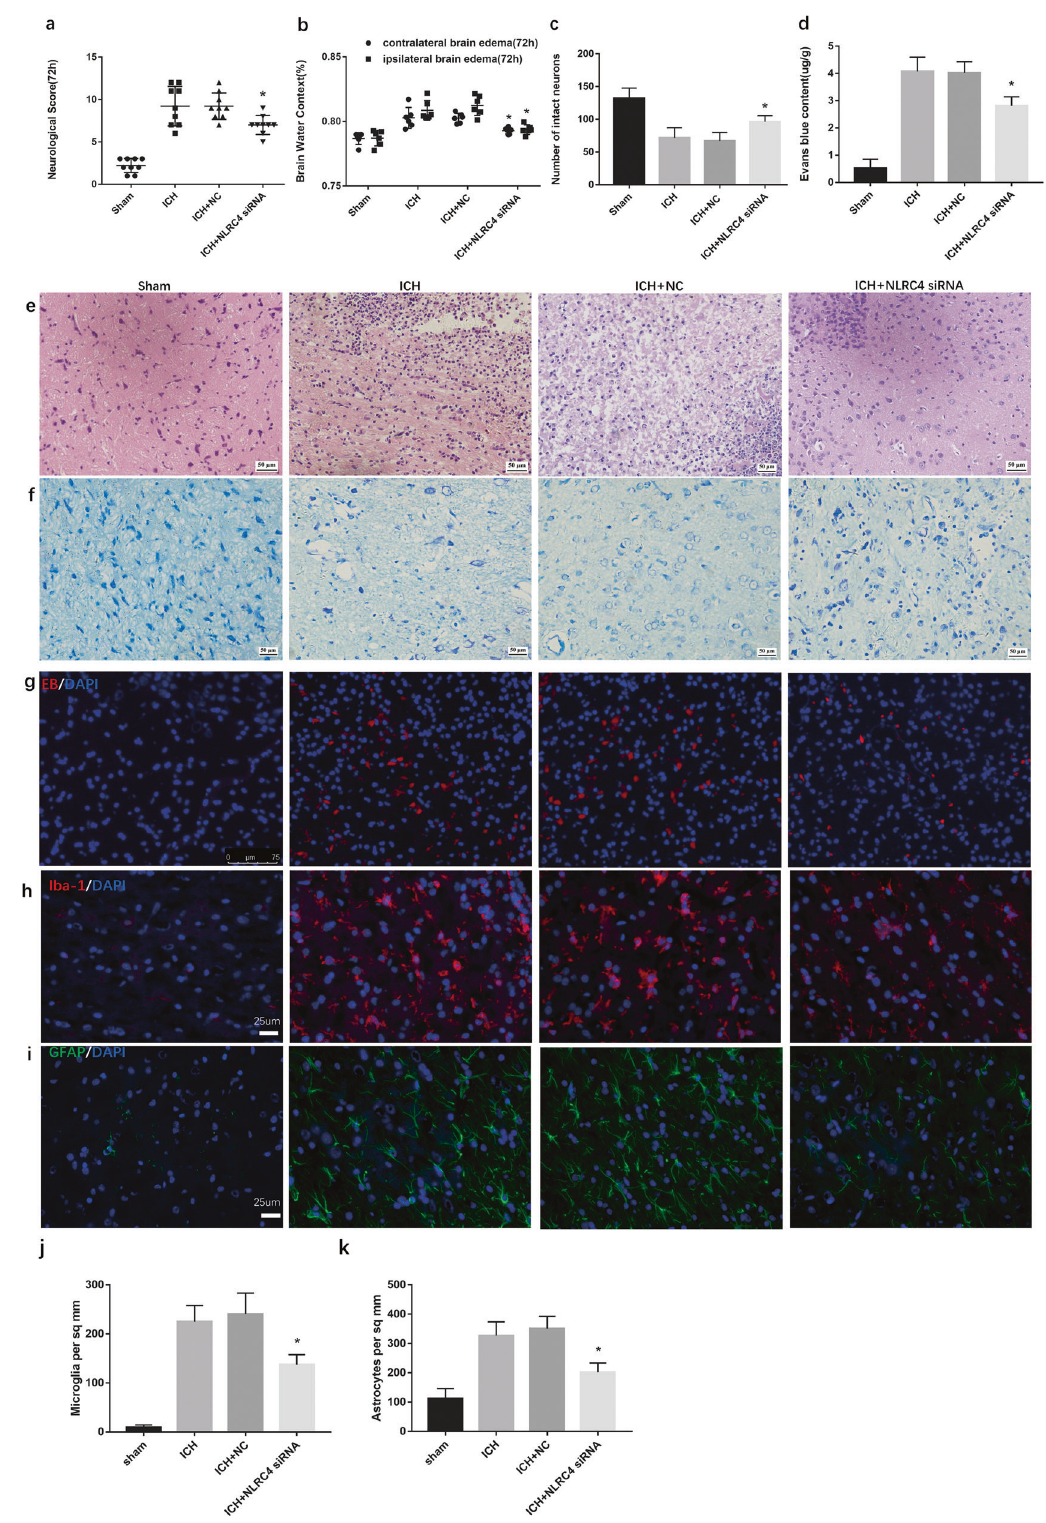
Fig. 3 NLRC4 knockdown reduced accumulation of glial cells, neurological function damage and decreased brain edema after ICH. a Modi fi ed Neurological Severity Scores (mNSS) for neurological function, b Brain edema in ipsilateral brain and contralateral brain for brain water content, e HE staining for the morphology (×400), f Nissl staining for the morphology (×400) and c Nissl staining for the number of nissl bodies, d Evans blue Dye extravasation and g auto fl uorescence (×400) for the integrity of blood brain barrier, h IF of Iba-1 staining for microglia. i IF of GFAP staining for astrocytes. Quanti fi cation of microglial accumulation ( j ) and astrogliosis ( k ) in the Sham, ICH, ICH + NC, and ICH + NLRC4 siRNA groups at 72 h after ICH. The data represent the means ± SEM. (six rats for each group). * P < 0.05, compared with